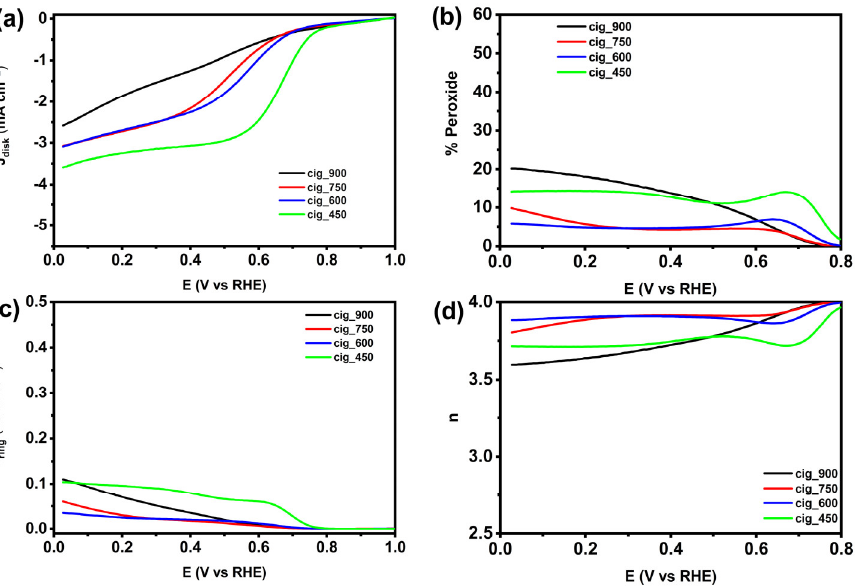
Figure 6. RRDE results of the samples in acidic media: ( a ) Disk current density (J disk ) and ( c ) Ring current density (J ring ) recorded at 1600 rpm and 5 mV s −1 , ( b ) % Peroxide and ( d ) the number of transferred electrons (n). Table 2. Electrochemical data of the samples in the tested electrolyte. Acid Neutral